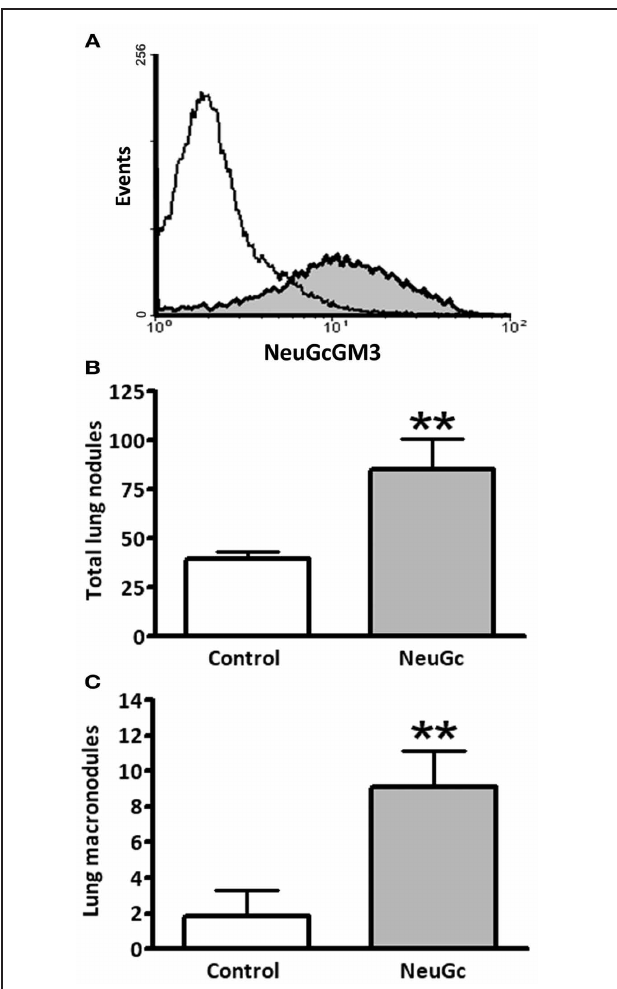
FIGURE 4 | Antitumor activity of racotumomab-alum vaccination in highly aggressive, NeuGcGM3-positive experimental lung tumors. Mice were vaccinated with racotumomab-alum (raco-alum) and then injected intravenously with control or NeuGc-preincubated 3LL cells, as described in “Materials and Methods.” (A) Total lung tumor nodules. (B) Lung macronodules ( > 2mm in diameter). Lung lesions are shown as mean ± SEM. ∗ p < 0 . 05, control versus raco-alum at 200 μ g/dose (ANOVA followed by Bonferroni’s multiple comparison test). macronodules of more than 2 mm in diameter ( Figures 3B,C ).